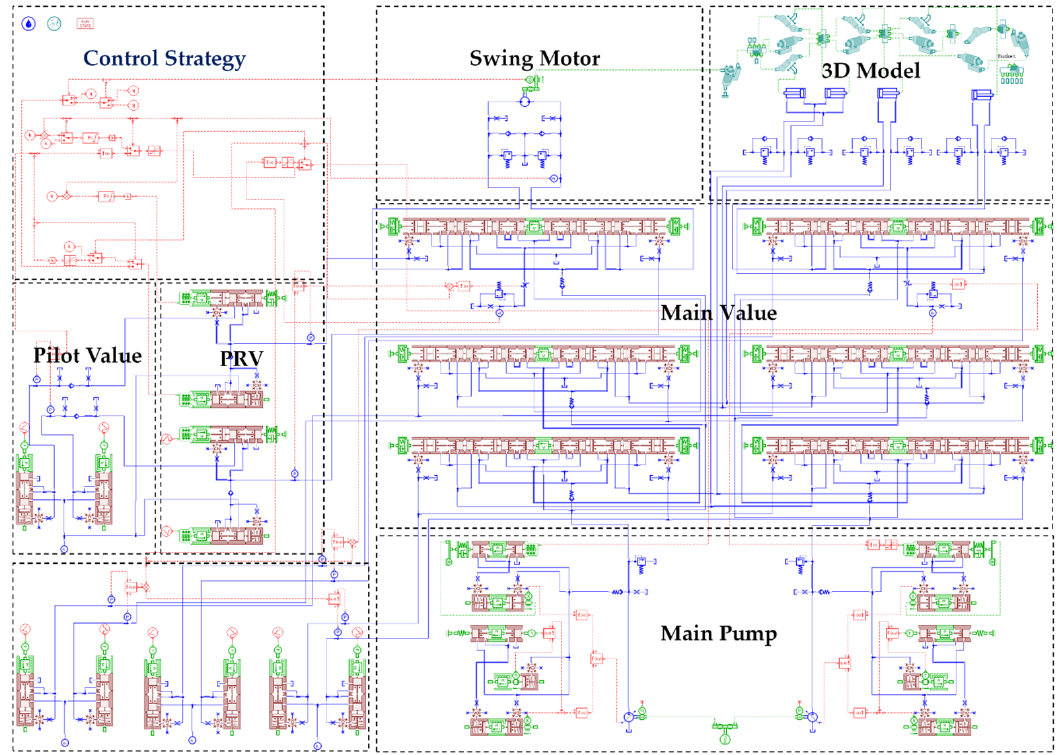
Figure 8. Simulation model of a 37-ton excavator.